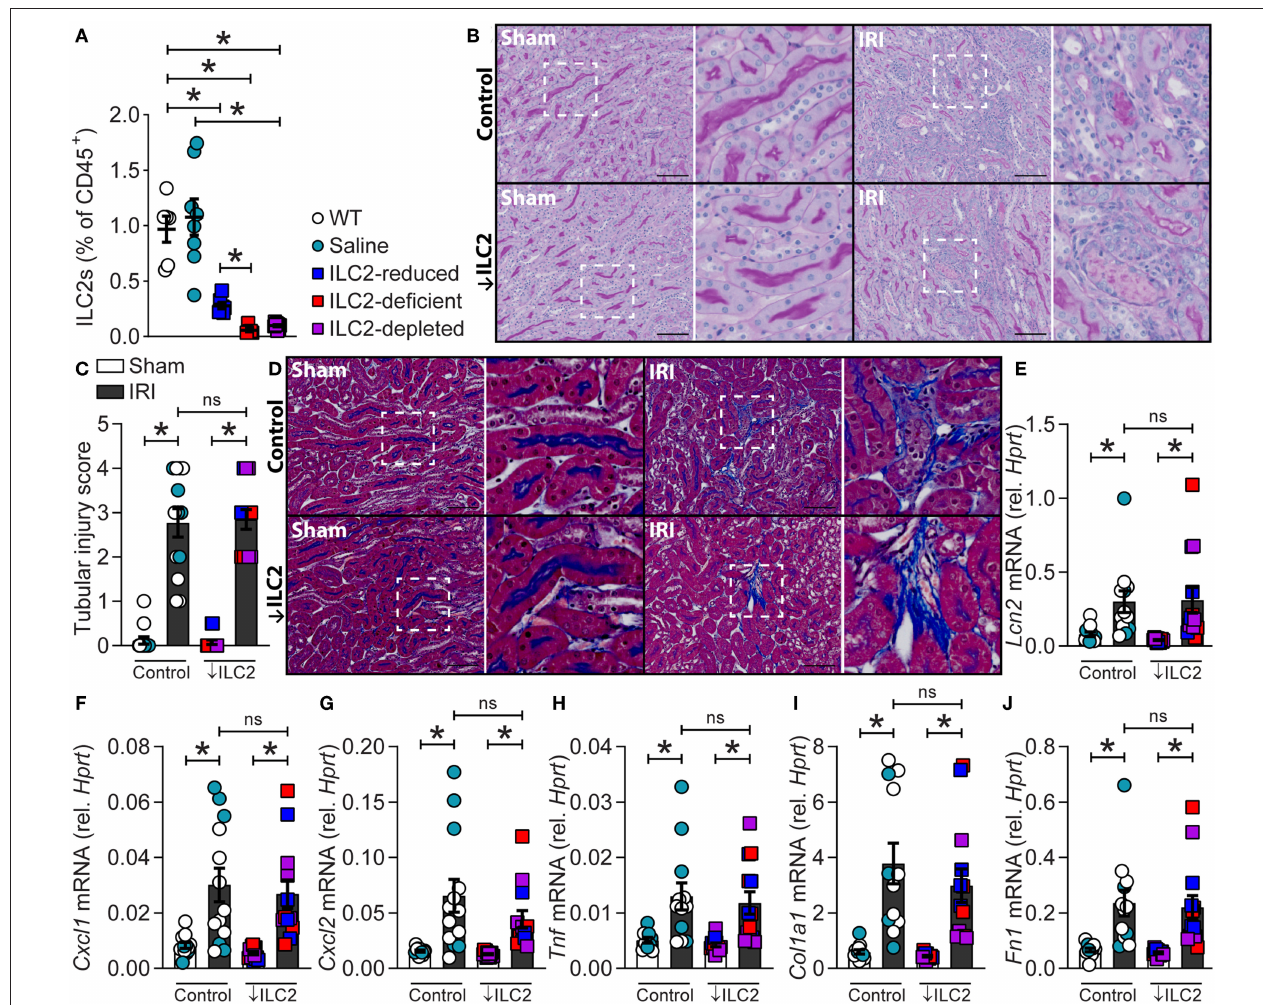
FIGURE 3 | A reduction, absence or depletion of ILC2s does not alter the severity of experimental renal ischemia-reperfusion injury. All mice were subjected to 29-min unilateral IRI with contralateral nephrectomy and were assessed compared to sham surgical controls for each genotype. All parameters were assessed 7 days after injury. (A) Kidney ILC2s (CD45 + Lineage − [TCR − [TCR αβ − TCR γδ − CD8 − CD4 − ]CD11b − GR-1 − B220 − TER-119 − CD3 − NK-1.1 − ]IL-7R α + CD90.2 + ST2 + FSC low SSC low single cells) as a percentage of CD45 + single cells from naïve C57BL/6JAusB wild-type (WT, n = 6; uncolored), vehicle (saline-treated Icos dtr / + Cd4 cre / + , n = 8; teal), ILC2-reduced ( Rora fl / + Il7r cre / + , n = 7; blue), ILC2-deficient ( Rora fl / fl Il7r cre / + , n = 5; red), and